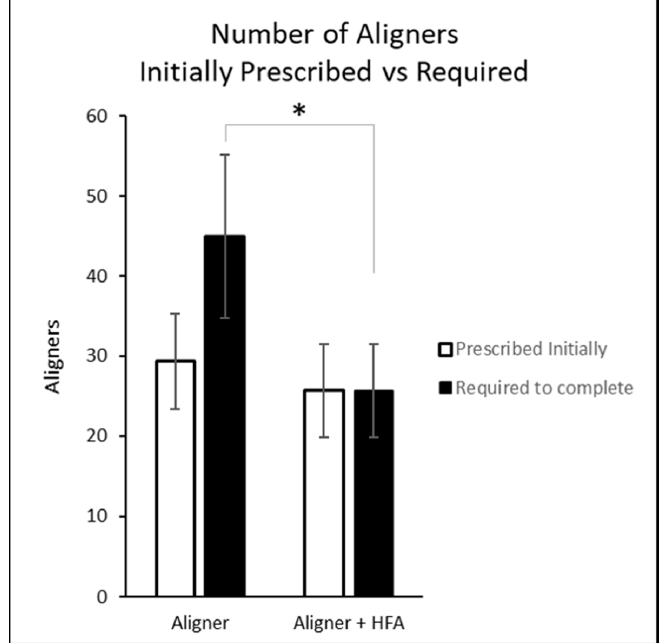
Figure 1. Number of aligners initially prescribed vs. required to complete treatment. * = Number of aligners required statistically significantly lower for Aligner + HFA group vs. Aligner group p < 0.05.